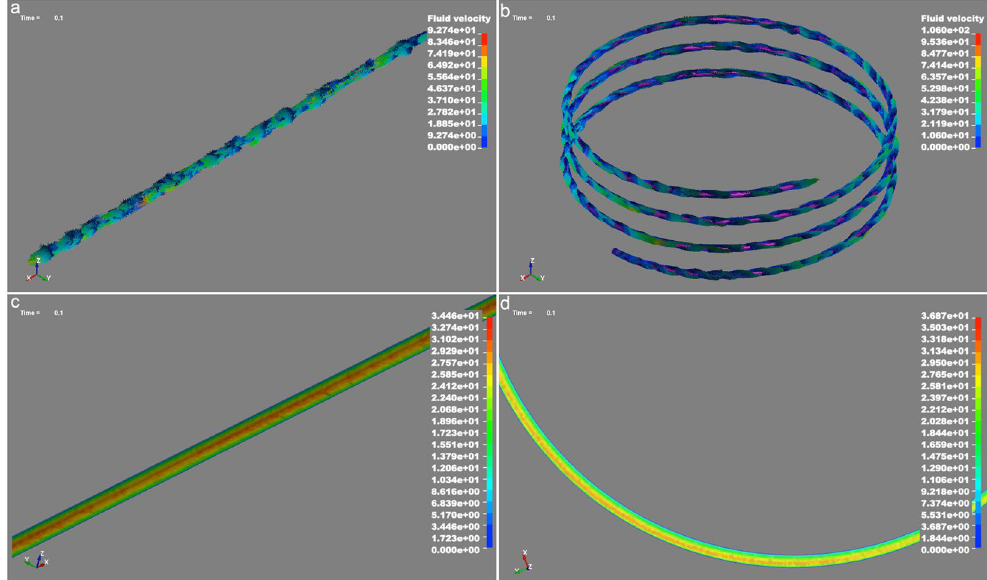
Figure 1. Fluid velocity in S1 and S2 for pass 0. ( a ) The fluid velocity vectors in S1. ( b ) The fluid velocity vectors in S2. ( c ) The contours of the average velocity at the central region of the length of S1. ( d ) The contours of the average velocity of S2 at a region far from the tube